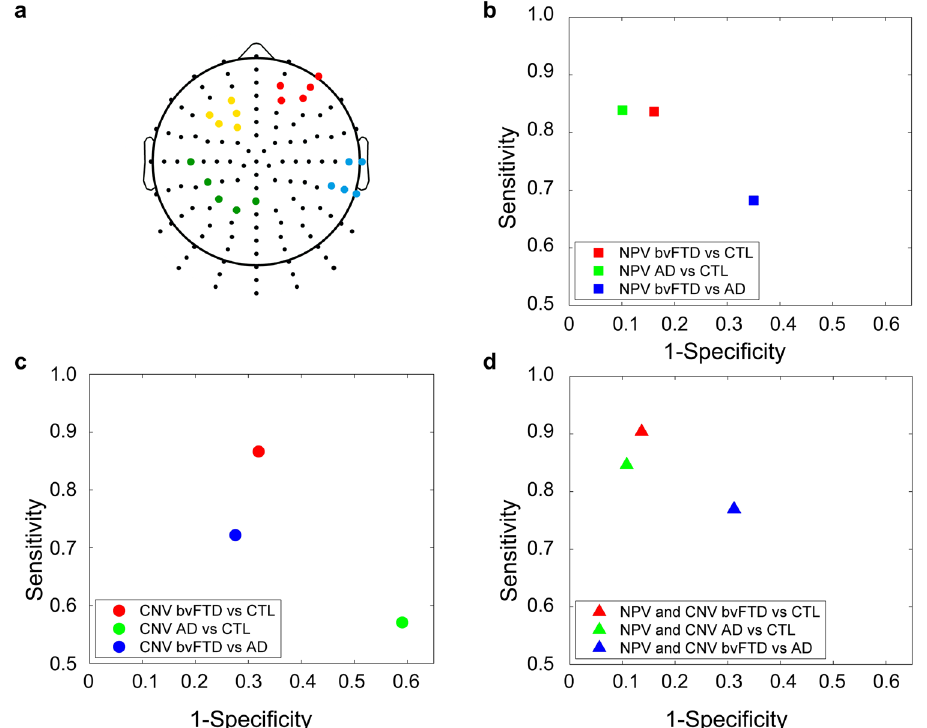
Figure 2. Classification analysis. ( A ) ROIs used for classification analyses. ROIs were defined are based on the major differences found in the seed analysis for the bvFTD comparison respect to controls: the light-blue and green one are the results from the first seed analysis (where we used the Frontal Left and Frontal Right seed from Fig. 1A), while the yellow and red one are the results from the second seed analysis, in which we used the light- blue and green ROIs from the first analysis as seeds. The average connectivity of these ROIs was used to define four of the CNV indexes for the classification analysis. ( B ) Classification analysis based on the NPS variables. The classification rates obtained were 83,8% for bvFTD vs Controls, 88,3% for AD vs Controls and 66,7% for bvFTD vs AD. ( c ) Classification analysis based on the CNV variables. The classification rates obtained were 72,7% for bvFTD vs Controls, 44,9% for AD vs Controls and 72,2% for bvFTD vs AD. ( D ) Classification analysis based on the combination of CNV and NPS variables. The classification rates obtained were 87,4% for bvFTD vs Controls, 88,0% for AD vs Controls and 72,9% for bvFTD vs